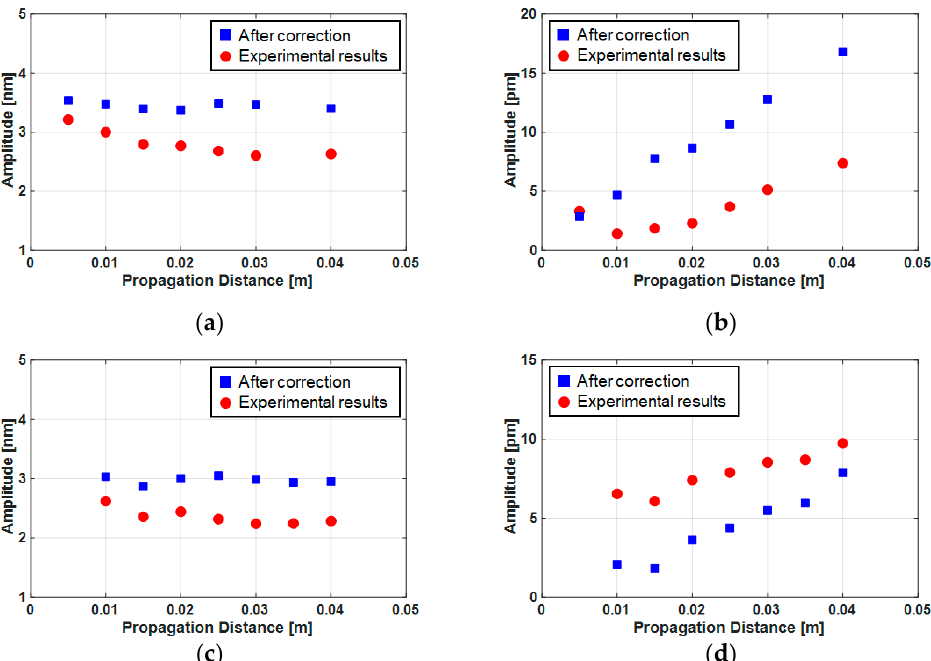
Figure 15. Results of the measurement and correction of the fundamental ( A 1 ( z ) ) and the second harmonic ( A 2 ( z ) ) displacement amplitudes: ( a ) fundamental component of fused silica, ( b ) second harmonic amplitude of fused silica, ( c ) fundamental component of Al6061-T6 and ( d ) second harmonic amplitude of Al6061-T6.